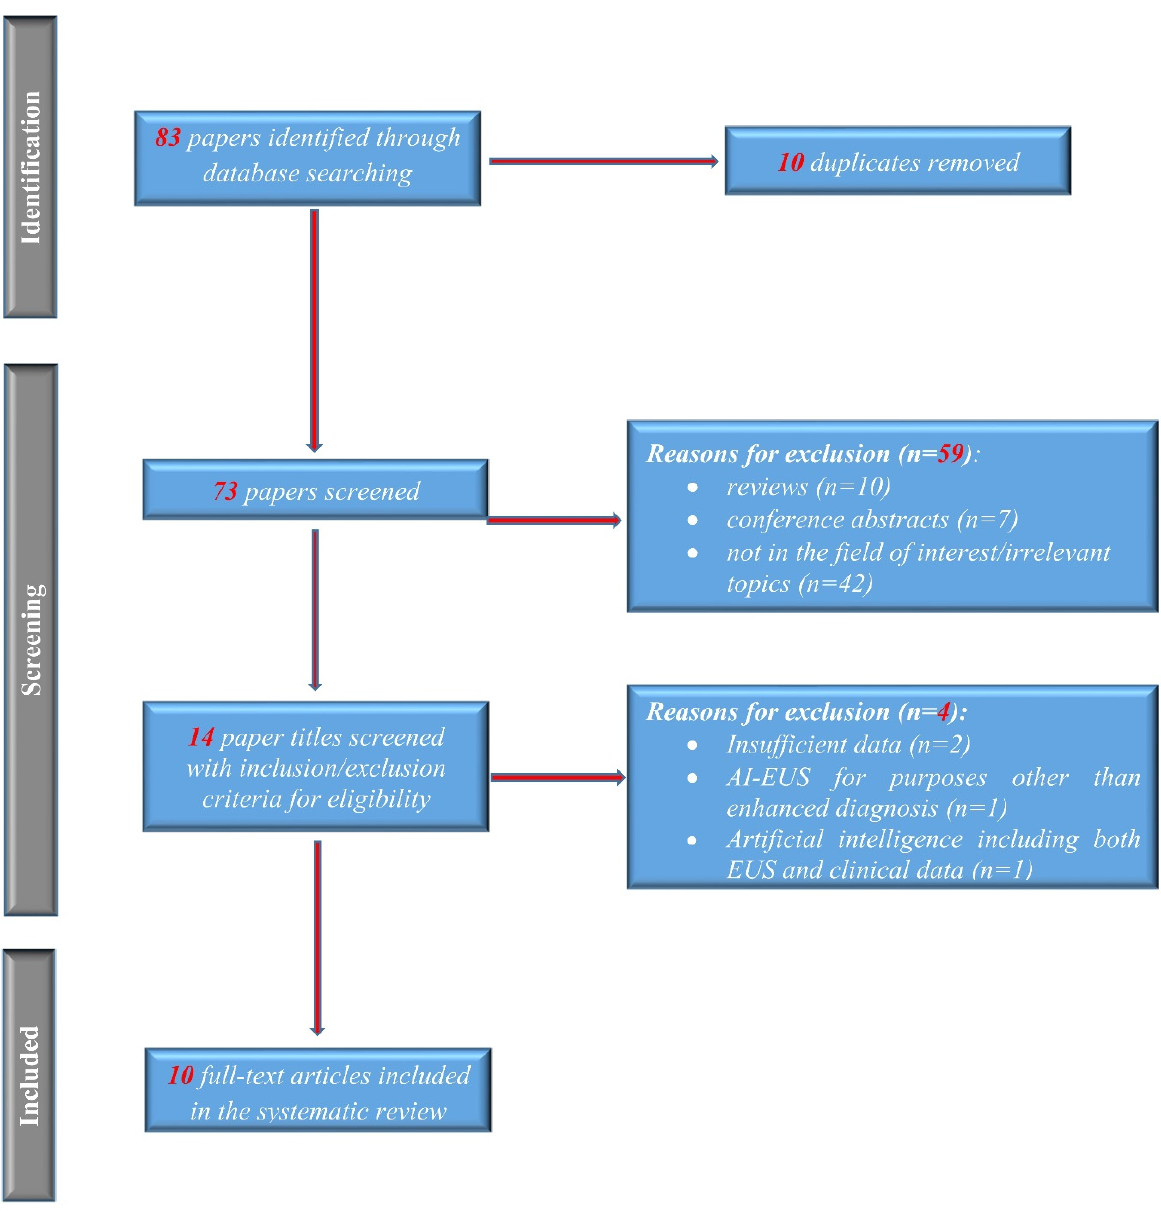
Figure 1. Study flow PRISMA diagram.